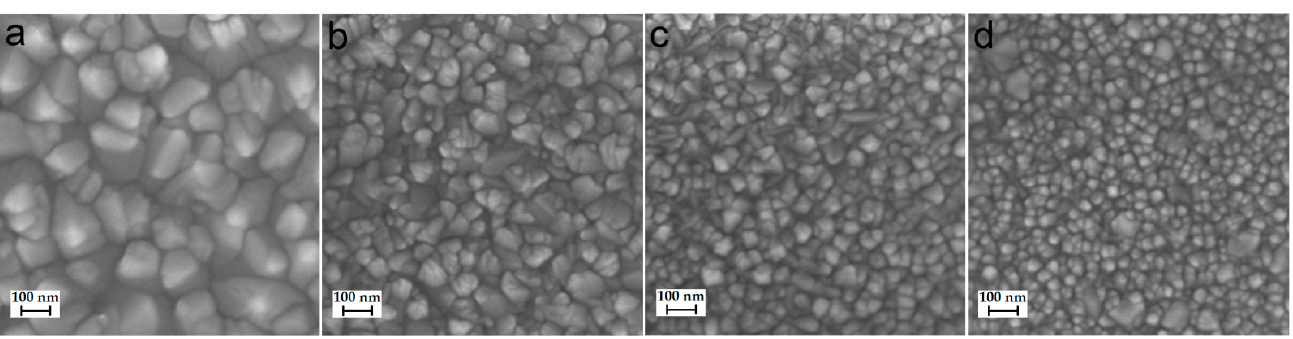
Figure 1. SEM images of TiO 2 coatings deposited on the silicon using TiCl 4 /H 2 O at 200 ° С ( a ), 250 ° С ( b ), 300 ° С ( c ), and 350 ° С ( d ).